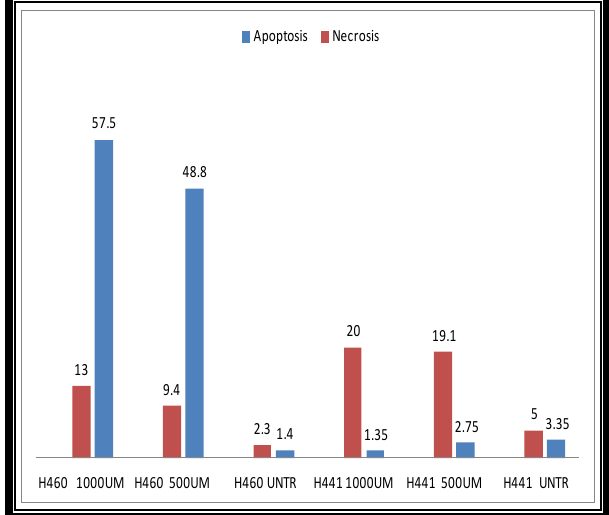
Figure 7 : Apoptosis and necrosis percentages after 48 hr of nicotine treatment with concentrations (500 μ M and 1000 μ M) in H460 and H441 lung cancer cells.